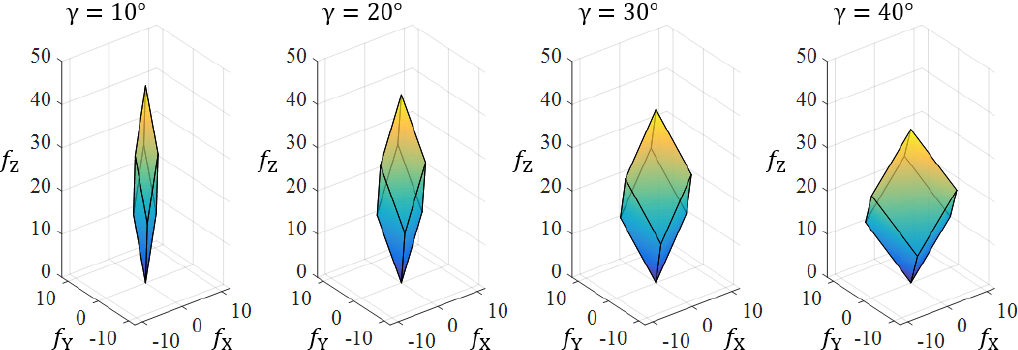
Figure 8. Propulsion force margins for PTX6 configuration consisting of EPUs setup 3.